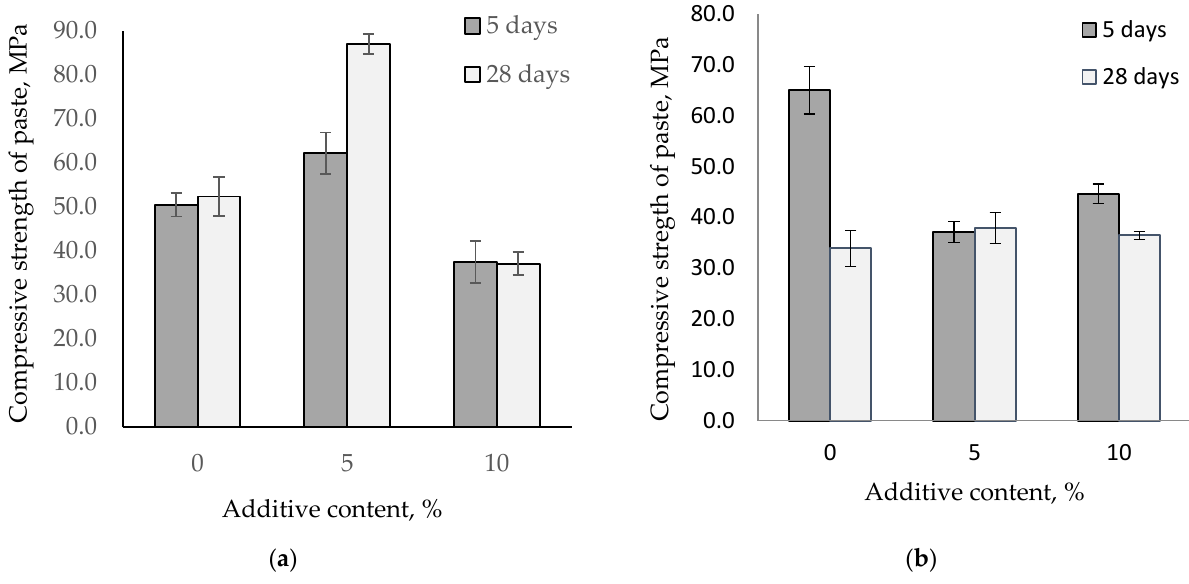
Figure 7. Compressive strength for the paste of HAC and CAC with glass stored at 40 °C. ( a ) HAC replacement by glass; ( b ) CAC replacement by glass.